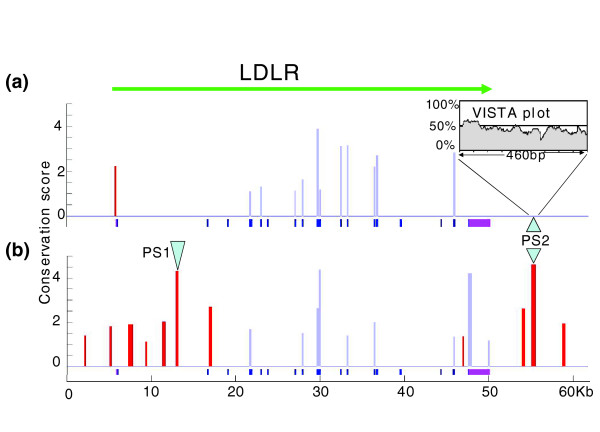
Conservation profiles of the LDLR locus using close (primate) and distant (human-mouse) species comparisons. (a) Human-mouse and (b) multiple primate (human, baboon, colobus, dusky titi, marmoset, and owl monkey) conservation profiles were calculated using Gumby and visualized using RankVISTA (see Materials and methods) and displayed with the human sequence as reference. Only about 6 kilobases (kb) of the 5' intergenic region is shown because of incomplete primate sequence availability. The entire 3' intergenic region was included in the analysis. Vertical bars depict conserved exonic (light blue) and nonexonic (red) sequences, with height indicating statistical significance of sequence conservation (see Materials and methods). LDLR coding exons (dark blue) and untranslated regions (UTRs; magenta) are marked below the conservation plots. Arrows denote the two highest-scoring primate-specific elements (PS1 and PS2). The inset shows the human-mouse VISTA plot for element PS2, with the vertical axis representing sequence identity calculated over a 100 base pair (bp) window.